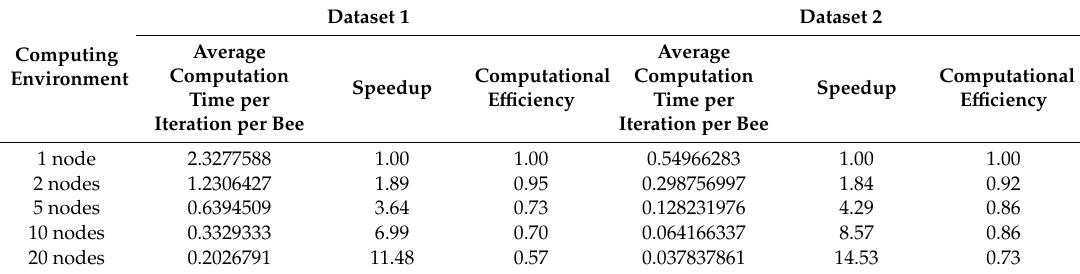
Table 9. Statistical Values of the Improved MA-based ABC Framework’s E ffi ciency Criteria.